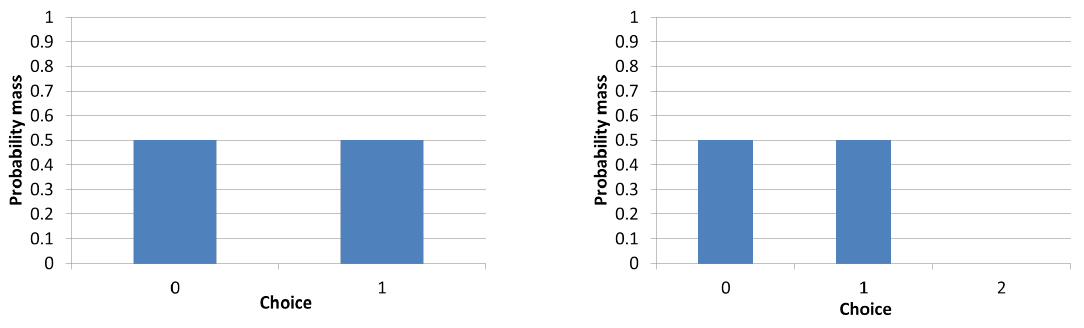
Figure 2. Compressed distributions using k = 2 and k = 3 for example from Figure